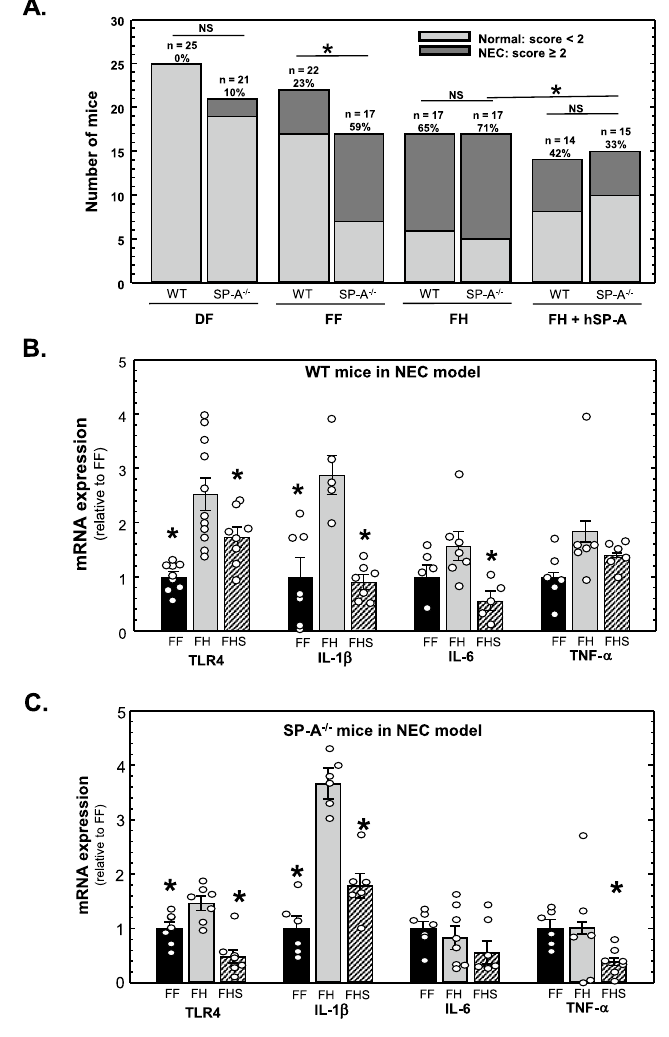
Figure 7. Gavage with SP-A reduces ileal damage, TLR4 and IL-1β in SP-A −/− mice in a neonatal mouse pup model of experimental NEC. ( A ) Assessment of ileal damage corresponding to NEC in WT and SP-A −/− mouse pups. Pups were subjected to the NEC procedure as described in “Methods”. FF formula fed, FH formula- fed + hypoxia, FHS formula-fed + hypoxia + gavaged human SP-A. Shown are the numbers of pups with scores suggesting little damage (assessment < 2) or NEC-like damage (assessment ≥ 2) in each group. * indicates P < 0.05, from ≥ 3 litters. ( B ) Expression of TLR4 mRNA and proinflammatory cytokine mRNA isolated from the ileum of WT mice subjected to the NEC procedure and assessed by quantitative real-time RT-PCR analysis. Shown are levels of expression relative to FF levels (set as 1). * indicates P < 0.05, n ≥ 6 from ≥ 2 litters. ( C ) Expression of TLR4 mRNA and proinflammatory cytokine mRNA isolated from the ileum of SP-A −/− mice subjected to the NEC procedure and assessed by quantitative real-time RT-PCR analysis. Shown are levels of expression relative to FF levels (set as 1). * indicates P < 0.05, n ≥ 6 from ≥ 2 litters. Figure created using SigmaPlot, ver 14, www.systa tsoft